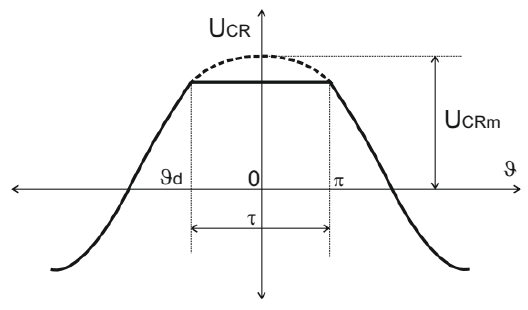
Figure 4. Voltage across the resonant capacitor.